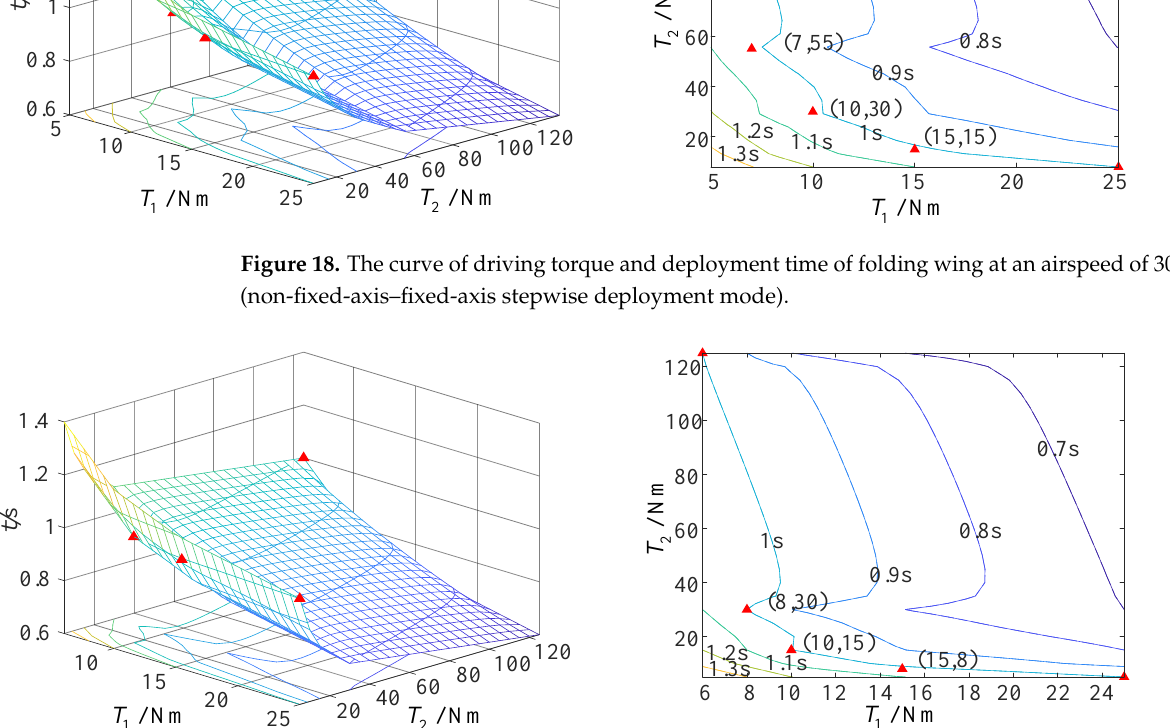
Figure 19. The curve of driving torque and deployment time of folding wing at an airspeed of 40 m/s (non-fixed-axis – fixed-axis stepwise deployment mode). When the non-fixed-axis – fixed-axis stepwise deployment mode is adopted and the airspeed is 50 m/s, the minimum driving torque required by axis 1 to complete the action is 13 Nm, and that required by axis 2 to complete the action is 5 Nm, on the premise that the folding wing can complete the action within 1 s, as shown in Figure 20.